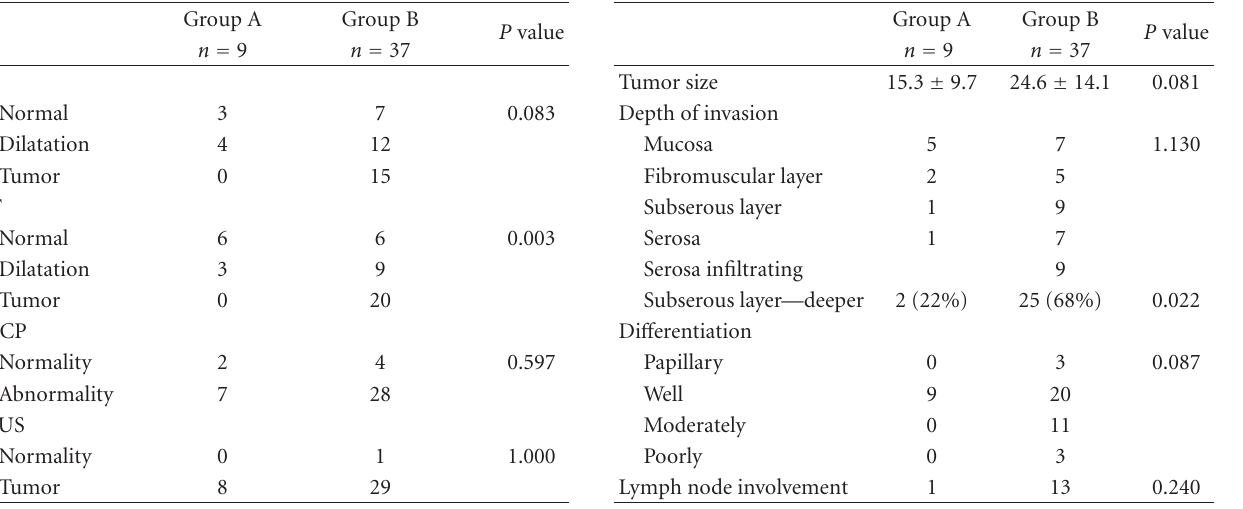
Table 5: Histological